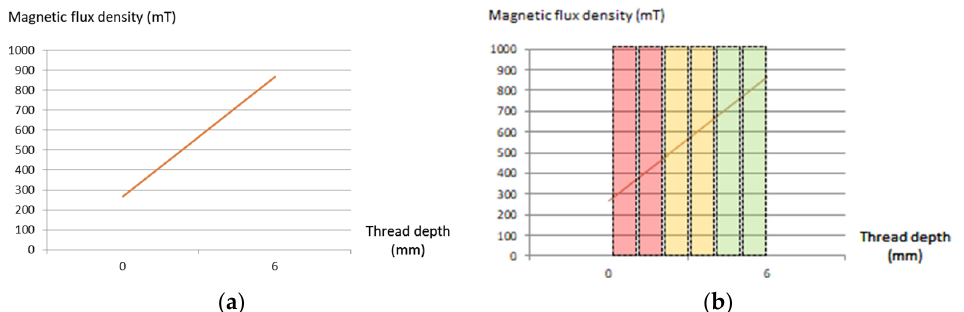
Figure 5. Wear status and magnetic field value: ( a ) tire magnetic flux density spec; ( b ) segmented the wear status based on tire magnetic flux density.